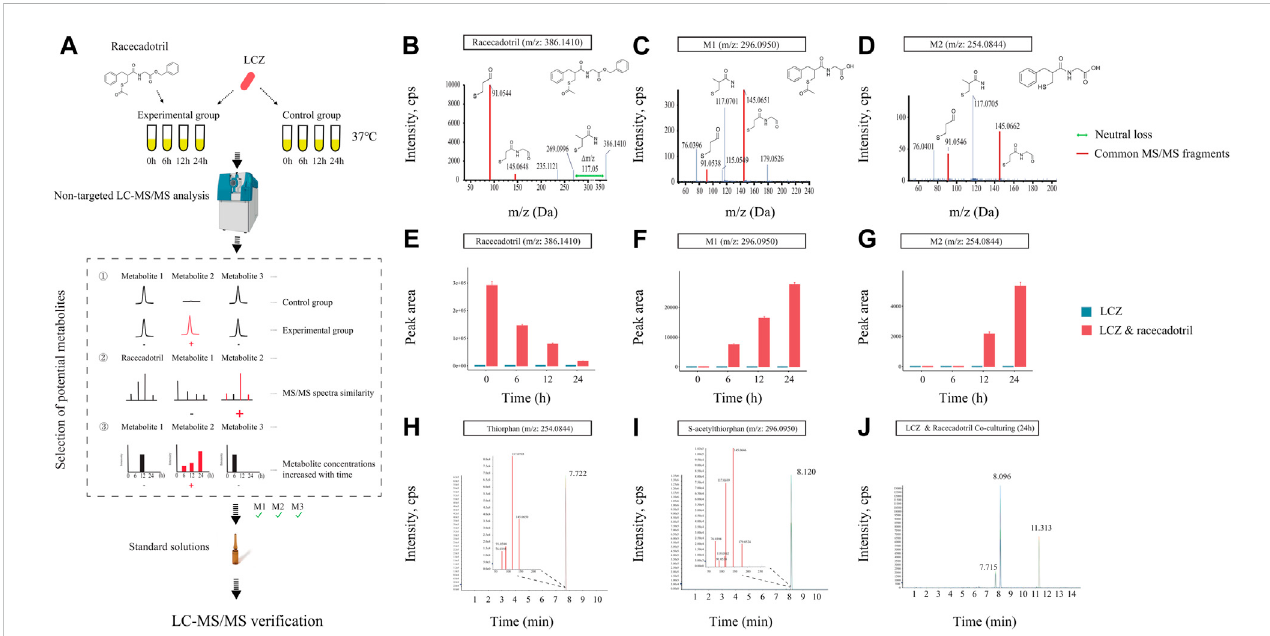
FIGURE 2 Identi fi cation of drug metabolites produced by L. casei Zhang (LCZ). (A) Schematic illustration of the assay. (B – D) Tandem mass (MS2) spectra of racecadotril and its metabolites, M1 and M2 (m/z = 296.0950, 254.0844, respectively). (E – G) The bar charts show the peak area of racecadotril and its candidate metabolites (M1 and M2) at different time points. Error bars represent SD. (H,I) Extracted ion chromatograms (XIC) of thiorphan and s-acetylthiorphan from authentic chemical standards. The insets show the enlarged peak clusters of their MS2 spectra. (J) The XIC of samples extracted from culturing LCZ in the presence of racecadotril, and the peaks corresponded to M2 (m/z: 254.0844), M1 (m/z: 296.0950), and racecadotril,